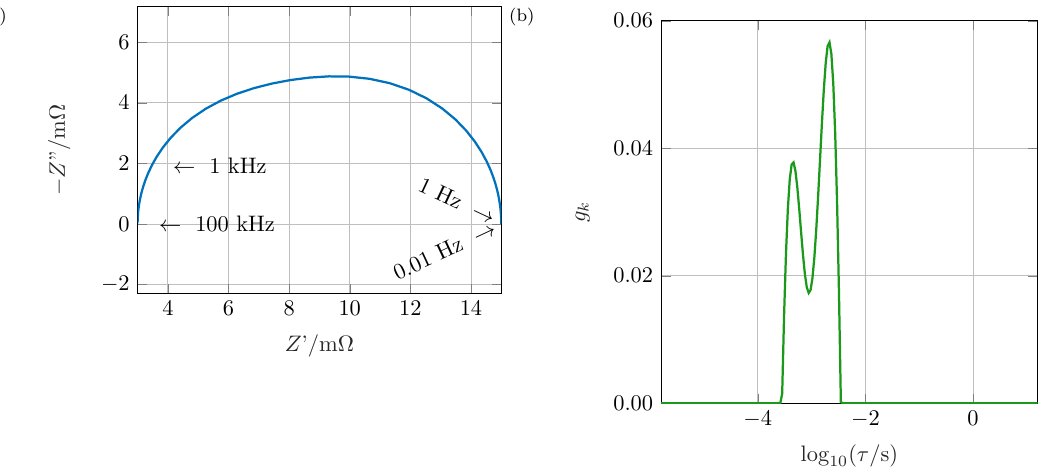
Figure 1. Impedance spectrum of two RC elements connected in series ( a ) appearing as a single, asymmetric semi-circle in the Nyquist plot; the distribution of relaxation times (DRT) ( b ) reveals both processes